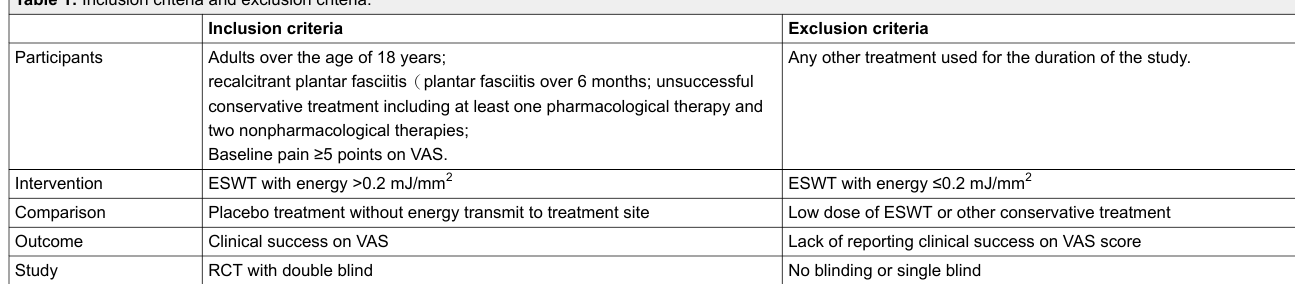
Table 1: Inclusion criteria and exclusion criteria.